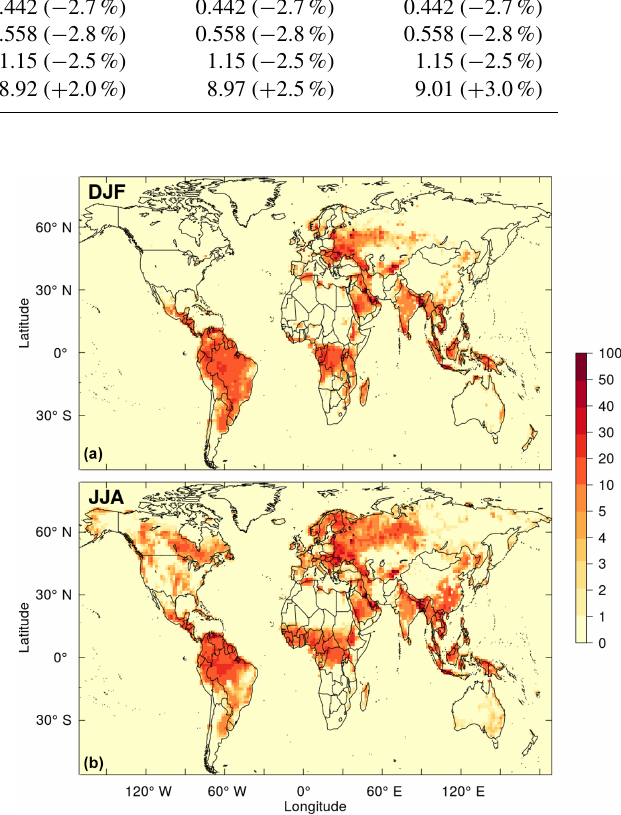
Figure 5. Global distribution of the simulated missing OH reactivity (in s − 1 ) in boreal winter (DJF, a ) and boreal summer (JJA, b ). rate of X is calculated as equal to the rate of removal of X within the turbulent boundary layer for each surface grid cell, according to Eq.